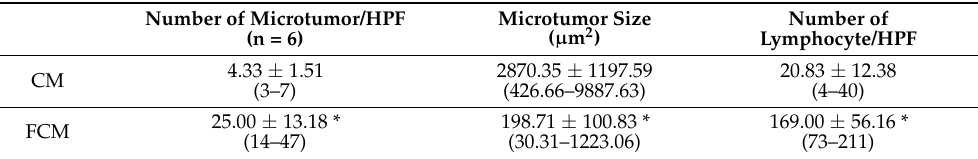
Table 1. Histological analysis of microtumor and inflammatory cell response.